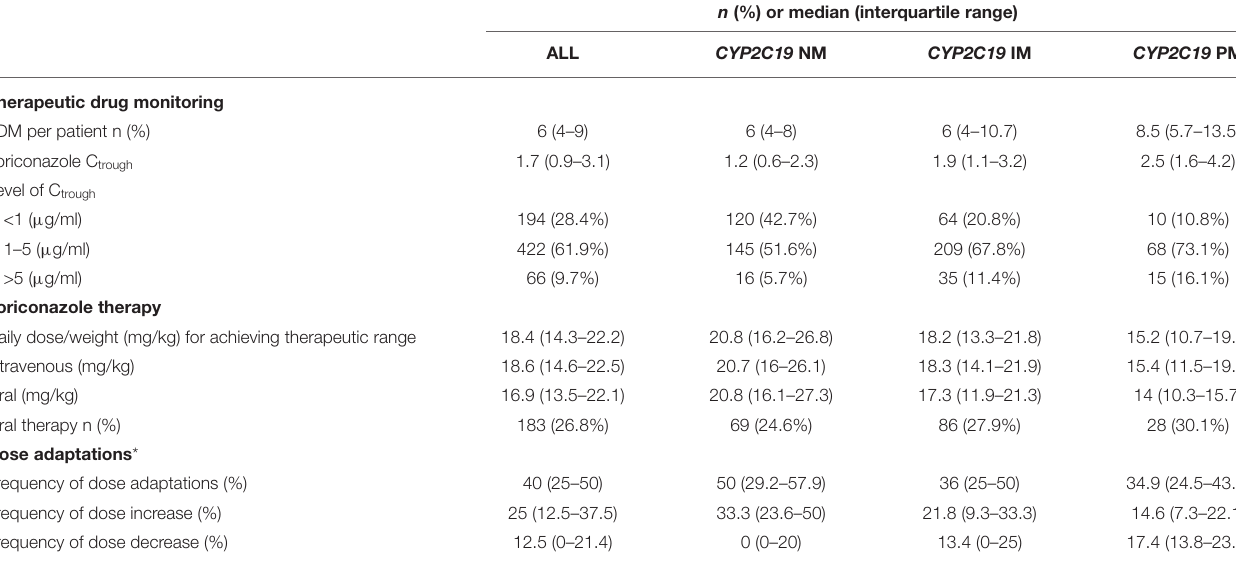
TABLE 2 | Voriconazole therapy, dose adaptation, and therapeutic drug monitoring.